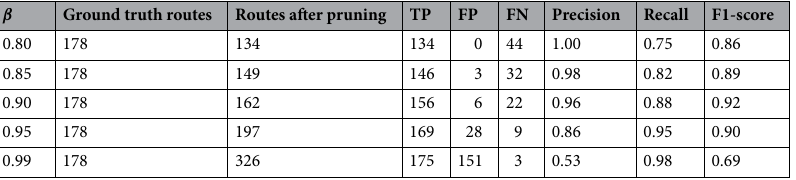
Table 4. Results for the triangle inequality pruned graph for the South Sudan case study with 93